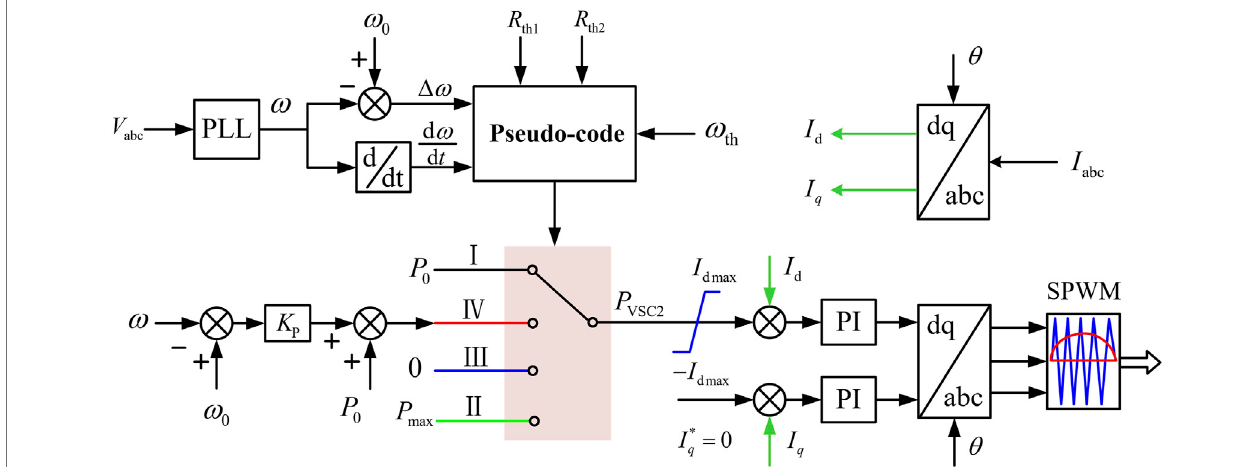
FIGURE 6 | Control block diagram combining RPC with droop